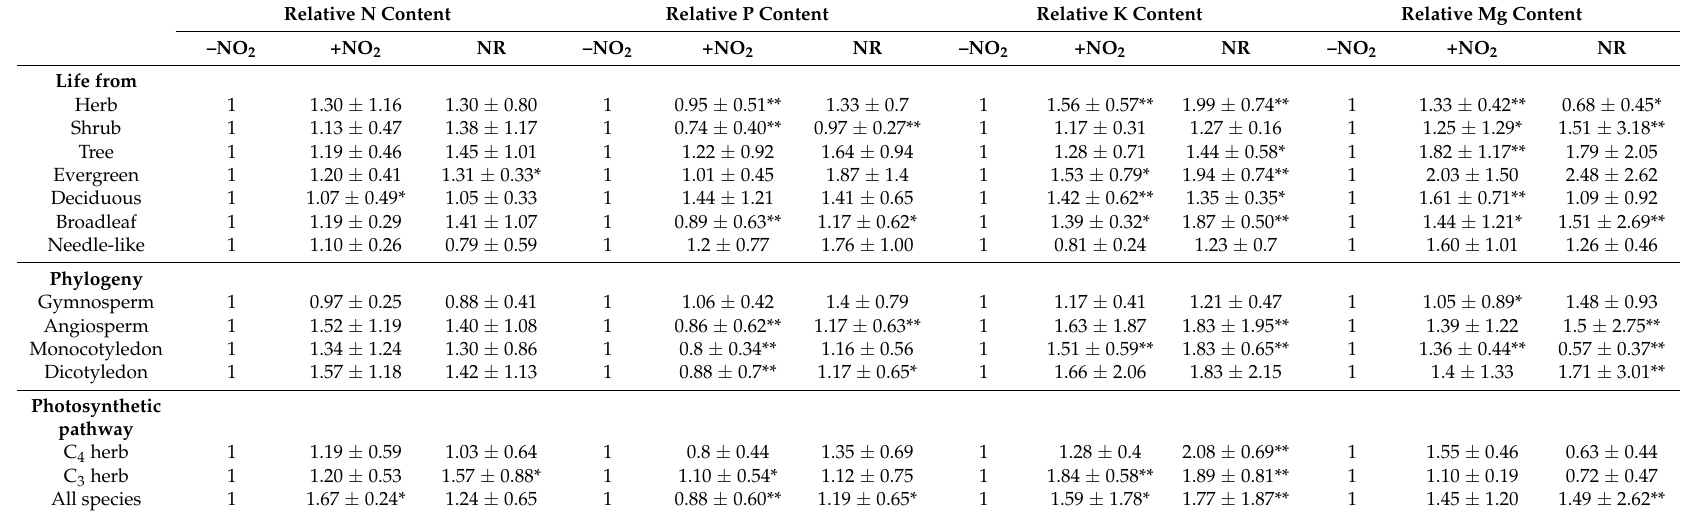
Table 4. Relative N, P, K, and Mg contents (folds) in different plant functional groups treated without nitrogen dioxide (NO 2 ) ( − NO 2 ), with 72 h NO 2 stress (+NO 2 ) or after 30 d of natural recovery